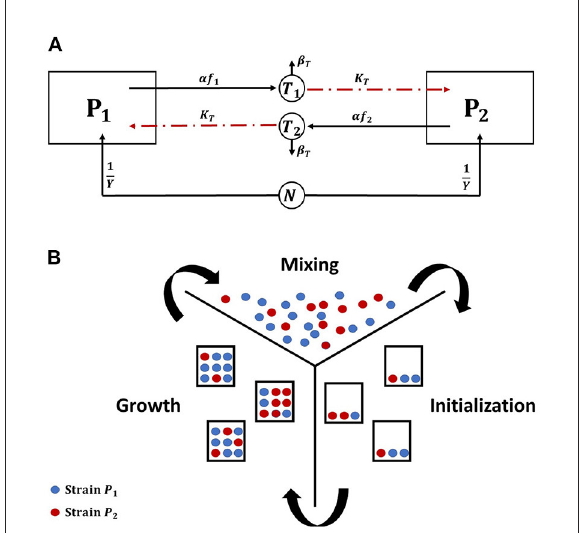
FIGURE1 (A) An illustrative diagram (Hashem and Van Impe, 2022a,b) of a competition between two constitutive toxin producers, where each strain is immune to its own toxin, growing together on the same nutrient. The diagram depicts two biological species, P 1 and P 2 , each denoted by a square, and three chemical species, N , T 1 , and T 2 , each denoted by a circle and representing the common nutrient and the toxins produced by P 1 and P 2 , respectively. The consumption of N as well as the production of T 1 and T 2 are denoted by solid lines, while the inhibiting effects of T 1 and T 2 on P 2 and P 1 , respectively, are denoted by dashed lines. (B) An illustration of the microbial life cycle model: a metapopulation of the two strains P 1 and P 2 is assumed to grow in a finite number of separate patches. The model consists of (i) an initialization step: all patches are seeded with the bacterial strains, (ii) a growth step: the growth dynamics is simulated in each patch separately until the population levels of all strains reach a steady state, and (iii) a mixing step: all patches are mixed with each other and the new composition of the metapopulation is used to initialize a new cycle of the